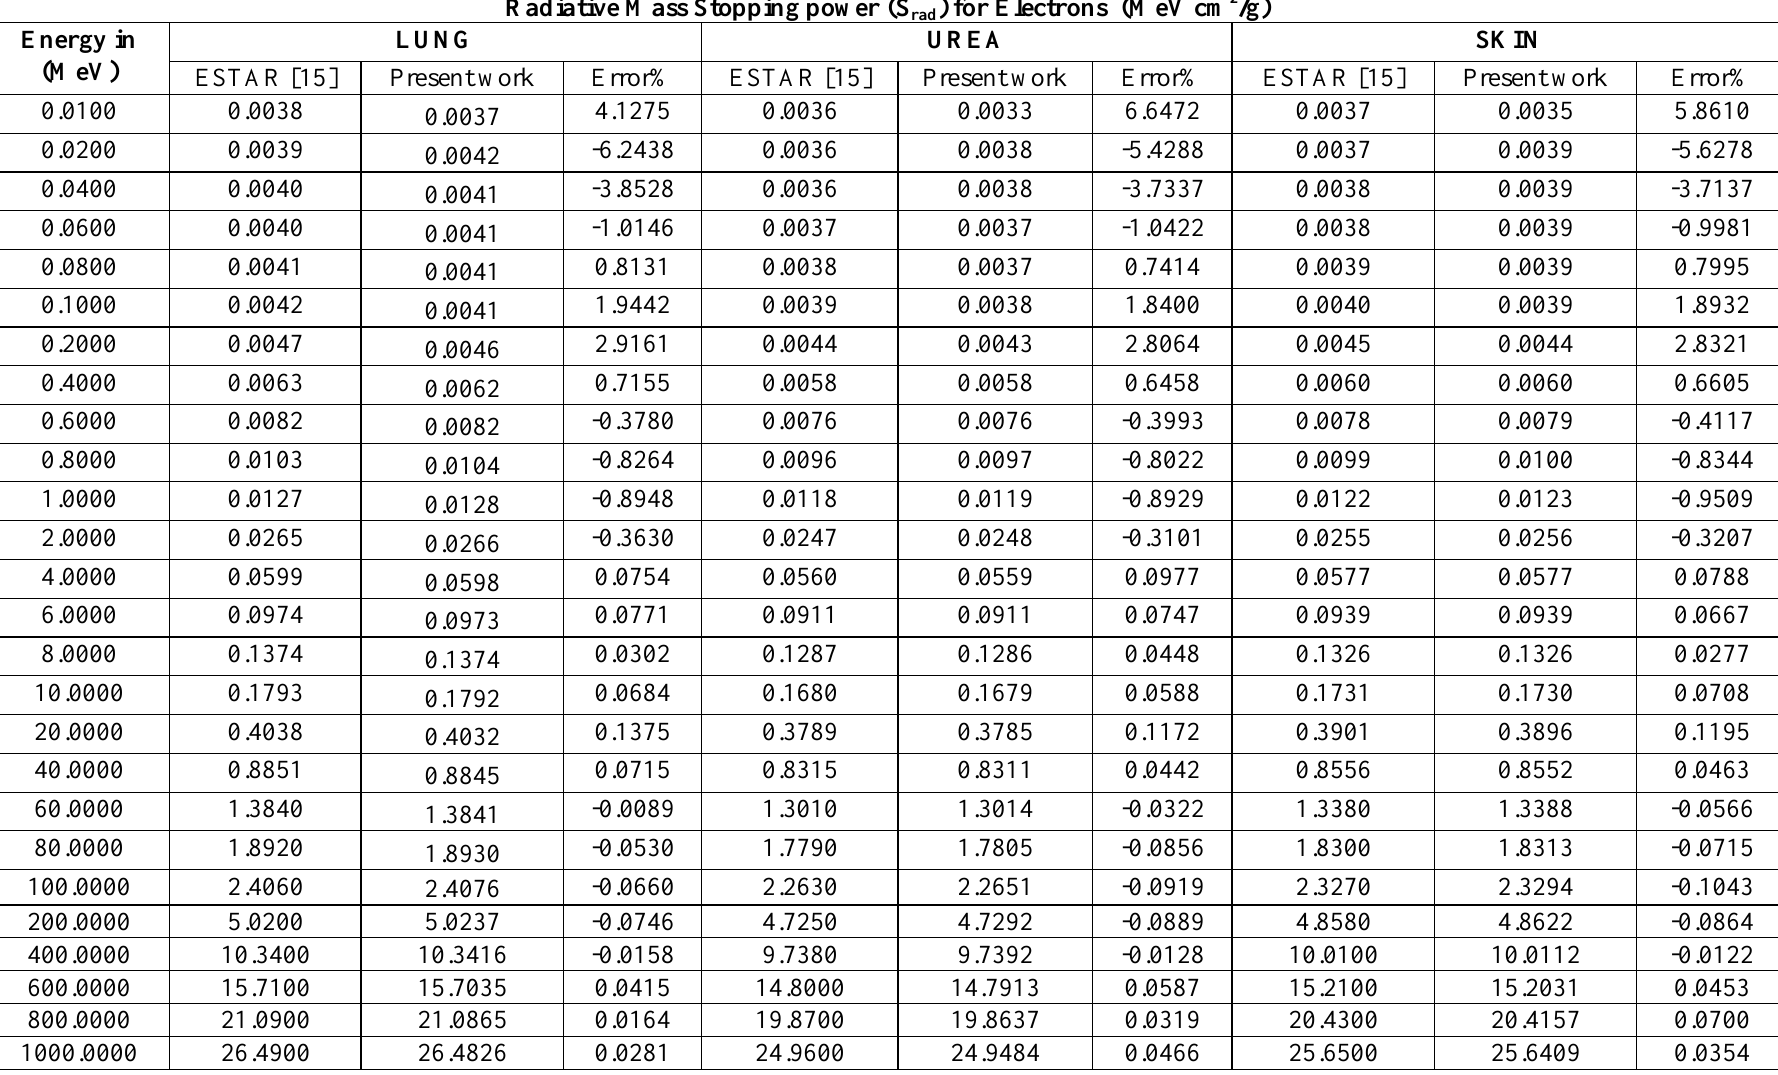
Table 2: Comparison of the present results of the radiative mass stopping power for electrons in Lung, Urea and Skin with the standard published data in the energy range (0.01-1000